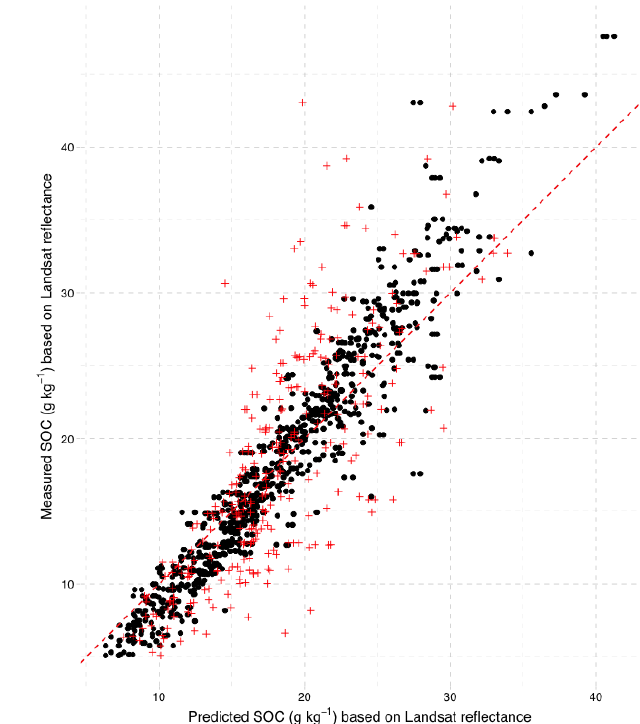
Figure 9. Predicted vs. measured SOC based on predictions made from Landsat 8 reflectance for the Kayonza and Nyagatare LDSF sites, Rwanda. The black dots are training data, while the red crosses show independent validation